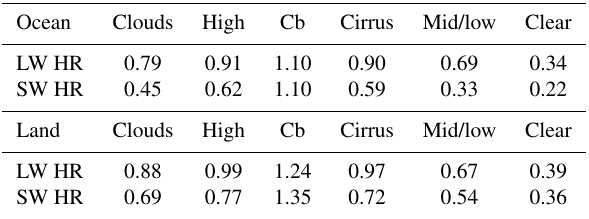
Table 3. MAE (K per day) for the prediction of LW and SW heating rates using models over different scene